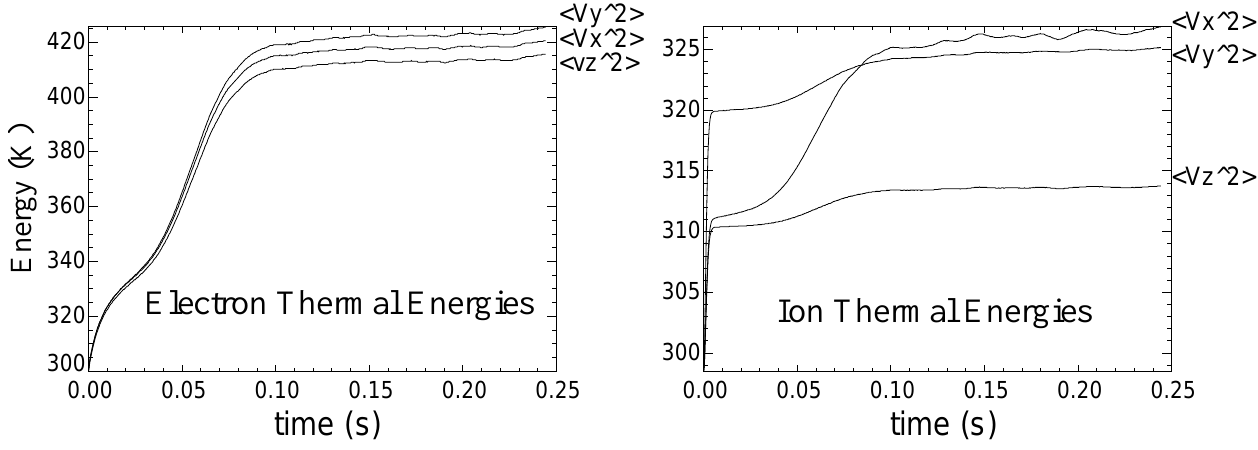
i /K b where j is the direction unit vector, j